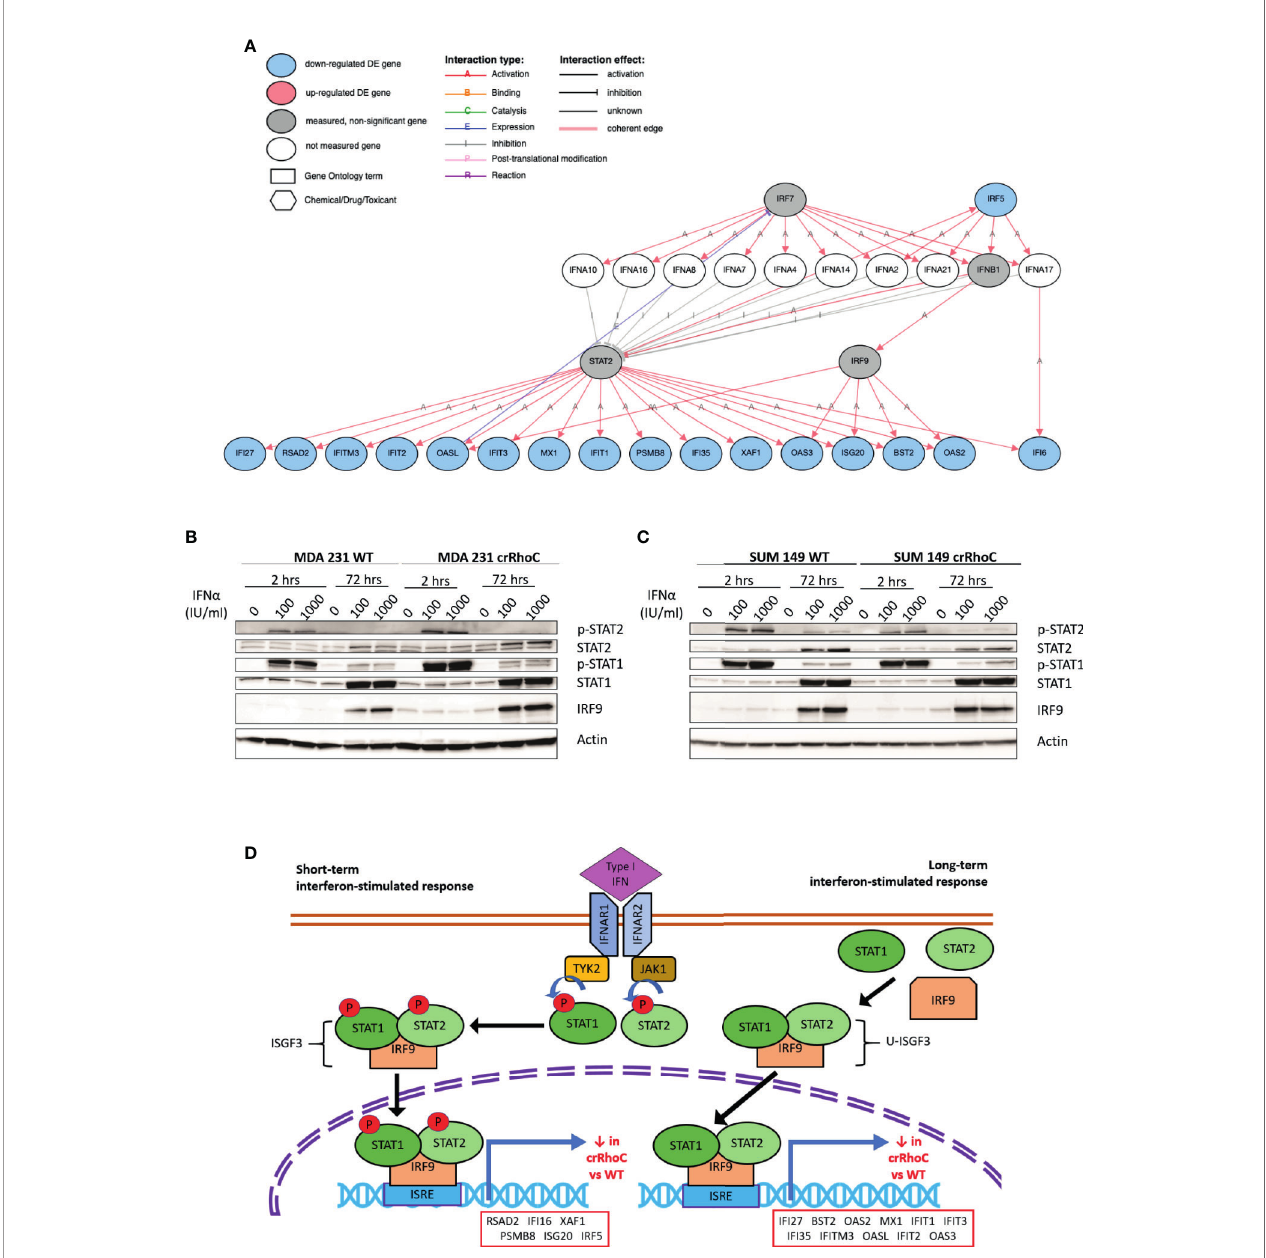
FIGURE 4 | RhoC expression in fl uences gene and protein expression of Type I interferon signaling response. (A) Type I interferon signaling pathway and the genes signi fi cantly downregulated in crRhoC knockout cells compared to wild-type, as measured in RNAseq. Genes in blue circles were downregulated in crRhoC compared to wild-type; genes in grey circles were not signi fi cantly differentially expressed between crRhoC and wild-type. (B) Western blot of interferon signaling markers in MDA 231 wild-type and crRhoC cells — crRhoC cells have increased p-STAT2 and IRF9 compared to wild type. (C) Western blot of interferon signaling markers in SUM 149 wild-type and crRhoC cells — crRhoC cells have decreased p-STAT2 and STAT2 compared to wild type. (D) Short-term and long-term signaling through type I interferon signaling pathways. Short-term interferon signaling is driven by phosphorylated STAT1 and STAT2 complexed with IRF9 that translocates to the nucleus, binds to interferon stimulated response elements (ISREs), and promotes transcription of interferon stimulated genes (ISGs); phosphorylation of STAT1 and STAT2 peak about 2 hours after treatment with a type I interferon. Long-term signaling is driven by unphosphorylated STAT1 and STAT2 complexed with IRF9, and peaks around 72 hours after treatment with type I interferons. Genes listed in order of decreasing magnitude of log